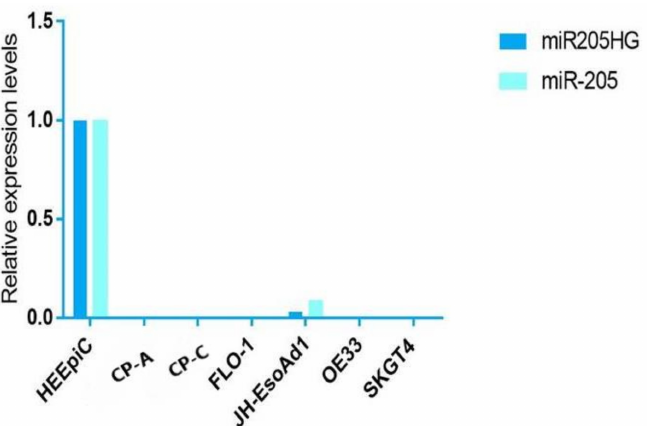
Figure 2. Expression levels of miR205HG and miR-205 in BE and EAC cell lines relative to NE (normal esophagus) cells. Expression levels of miR205HG and miR-205 are shown in BE ( CP-C and CP-A ) and EAC (OE33, Flo-1, SKGT4, and JH-ea1) cell lines relative to NE ( HEEPiC -Human Esophageal Epithelial Cells) cells. Both miR205HG and miR-205 were neither not detectable or downregulated tenfold or greater in BE and EAC cells.